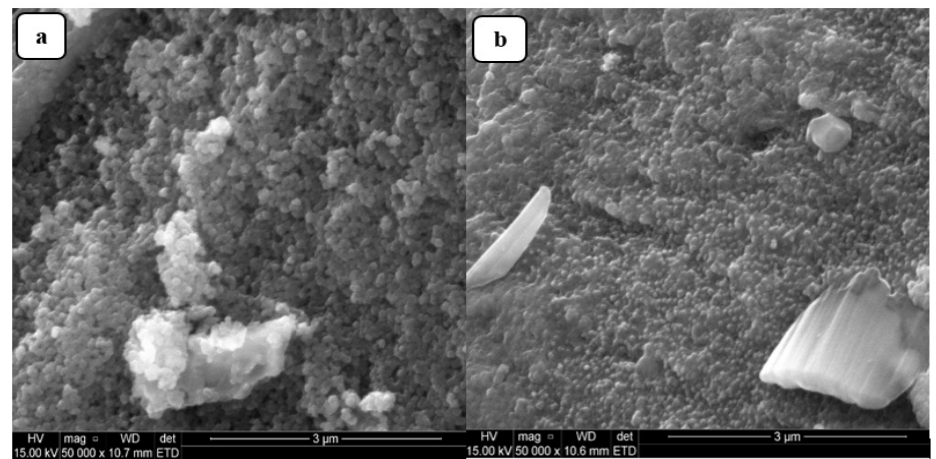
Figure 4. SEM micrographs of ( a ) Fe 3 O 4 NPs and ( b ) nanocomposite (Fe 3 O 4 /SPEEK).